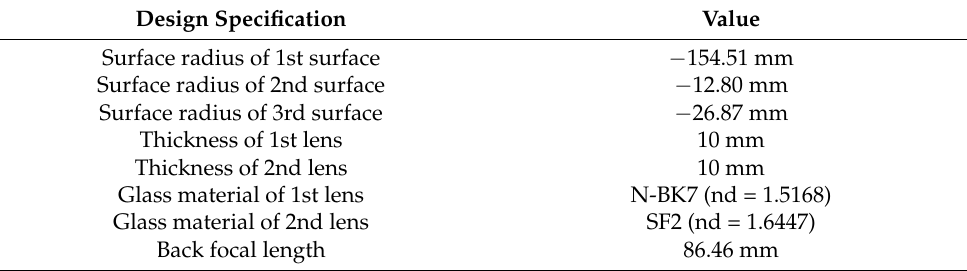
Figure 4. Design of focusing lens using temporary object points. ( a ) Ray tracing in original optical system layout; ( b ) ray tracing from temporary object points. Table 3. Specifications of designed focusing lens.